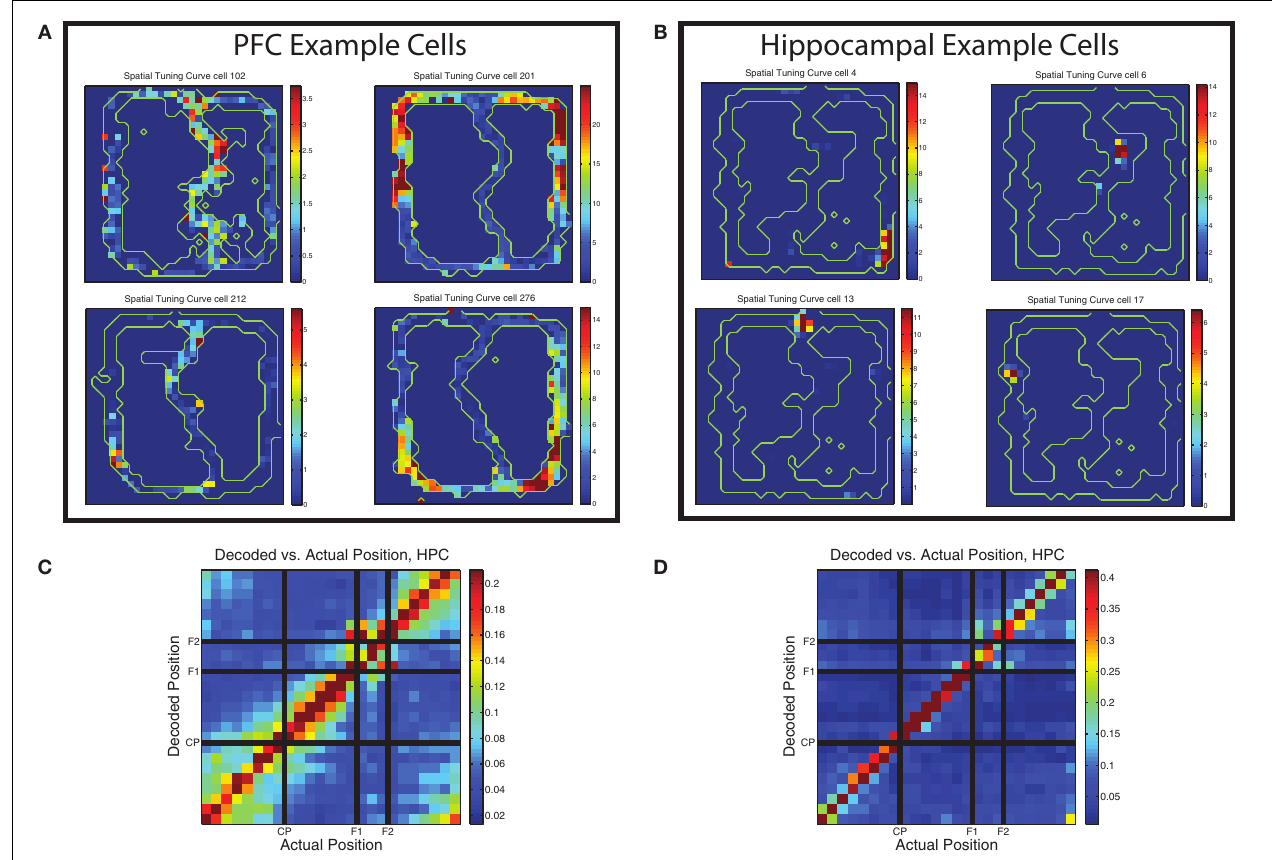
FIGURE 10 | Prelimbic cells show non–uniform spatial firing. (A) Typical spatial tuning curves of prelimbic cells from this data set. Note the large firing response fields, typically covering a broad region of the maze and usually present on both left and right sides of the track. Color bars indicate firing rate in Hz. (B) Typical spatial tuning curves of hippocampal cells from the same task. Note the smaller firing response fields, more typical of hippocampal place cells. Color bars indicate firing rate in Hz. (C) Decoding confusion